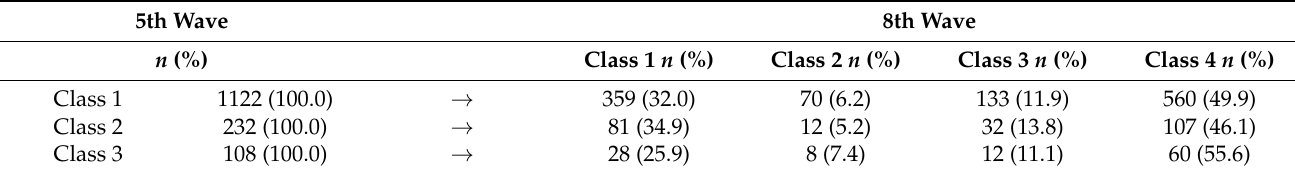
Table 4. Transition analysis of child-rearing